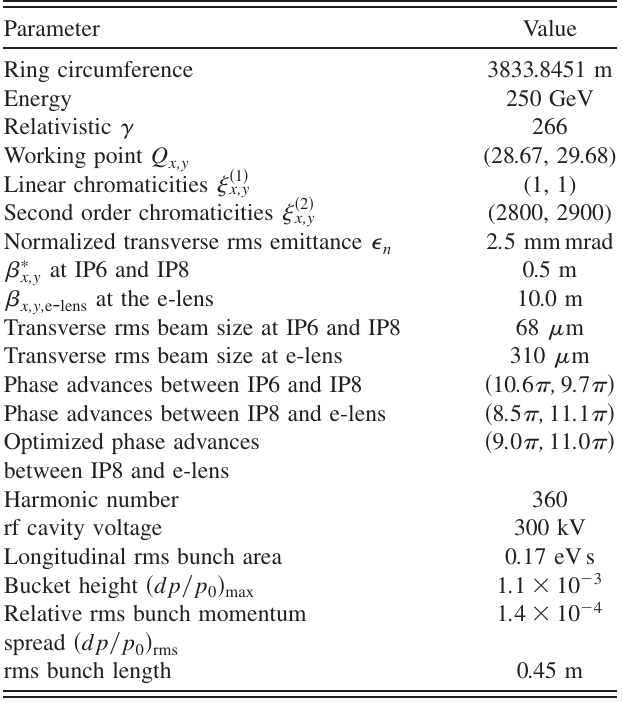
TABLE I. Lattice and beam parameters used in this study. Parameter